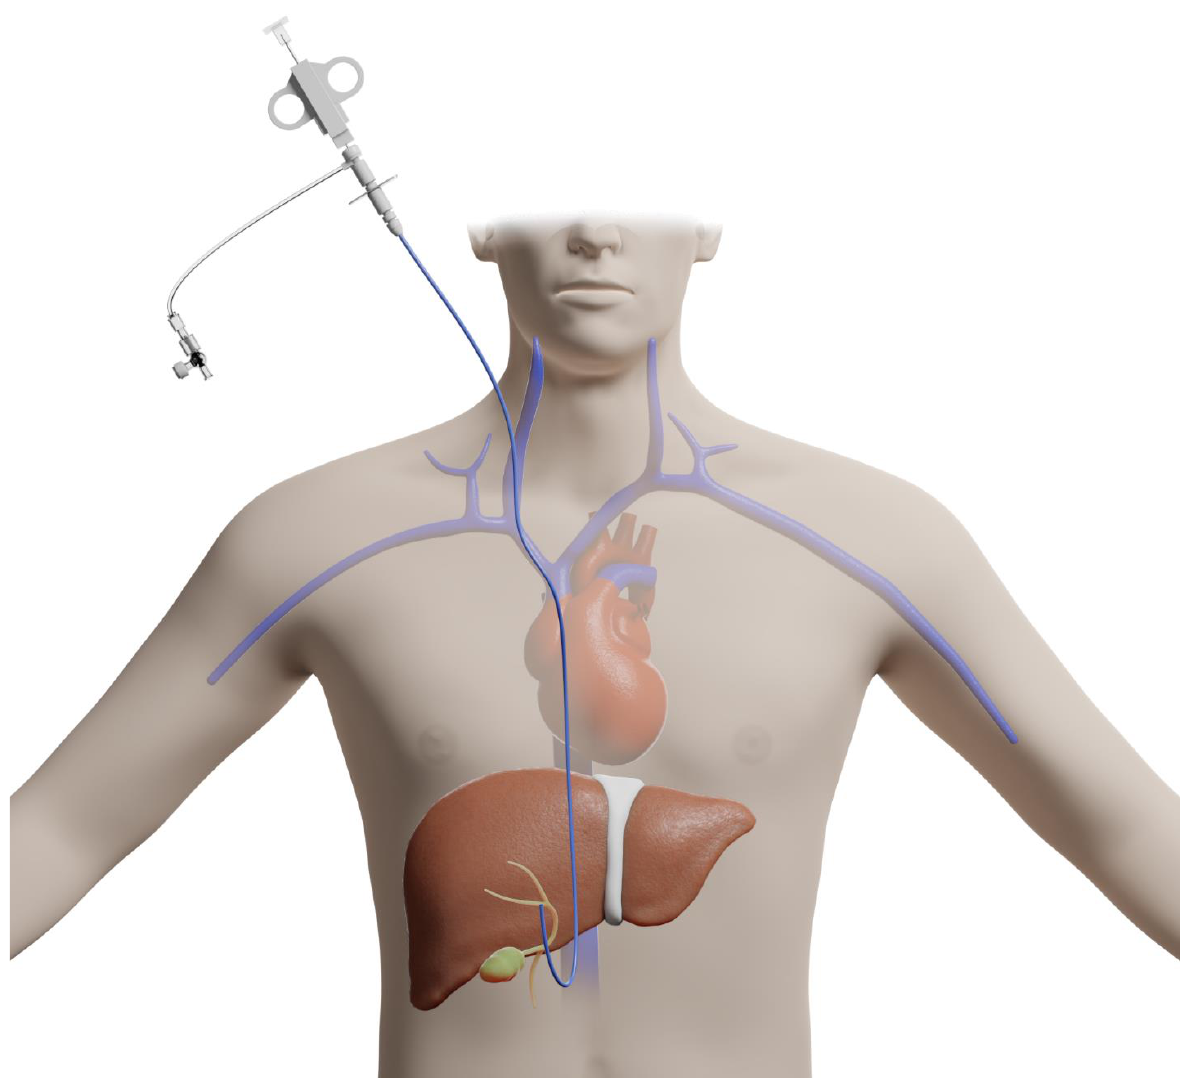
Figure 2. Illustration of a transjugular approach for liver